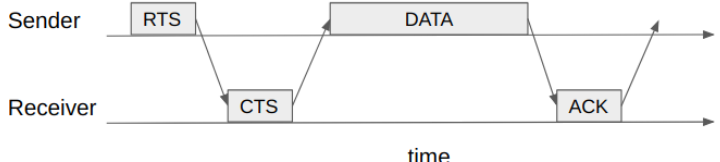
Figure 9. Exchange of packets for a successful channel reservation with request-to-send/clear-to-send (RTS/CTS) signaling in carrier sense multiple access with collision avoidance (CSMA/CA).